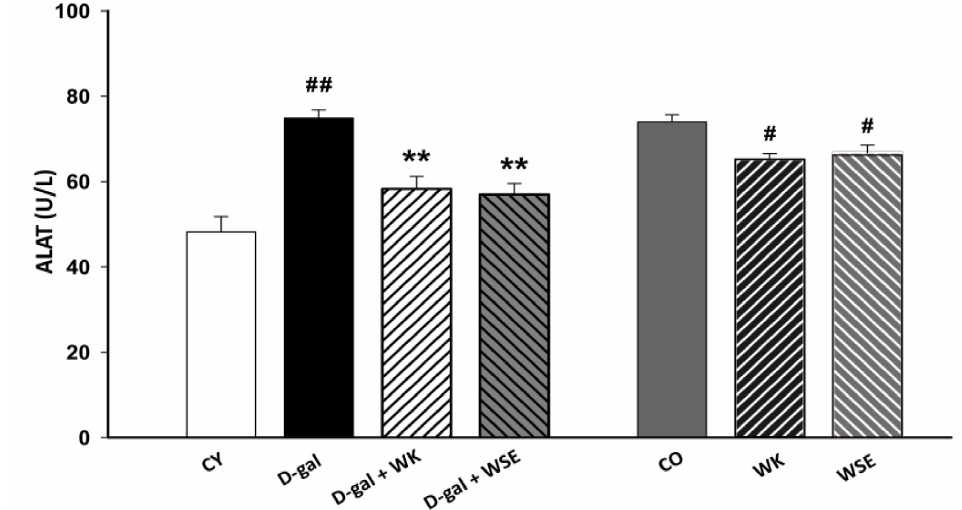
Figure 4. ALAT levels in D-gal-induced aging and naturally aged rats (values expressed as mean ± SD; n = 8); # p < 0.05 and ## p < 0.01 compared to CY or CO; * p < 0.05 and ** p < 0.01 compared to D-gal group (CO—control old; CY—control young; D-gal—D-galactose; WK—walnut kernel; WSE—walnut septum